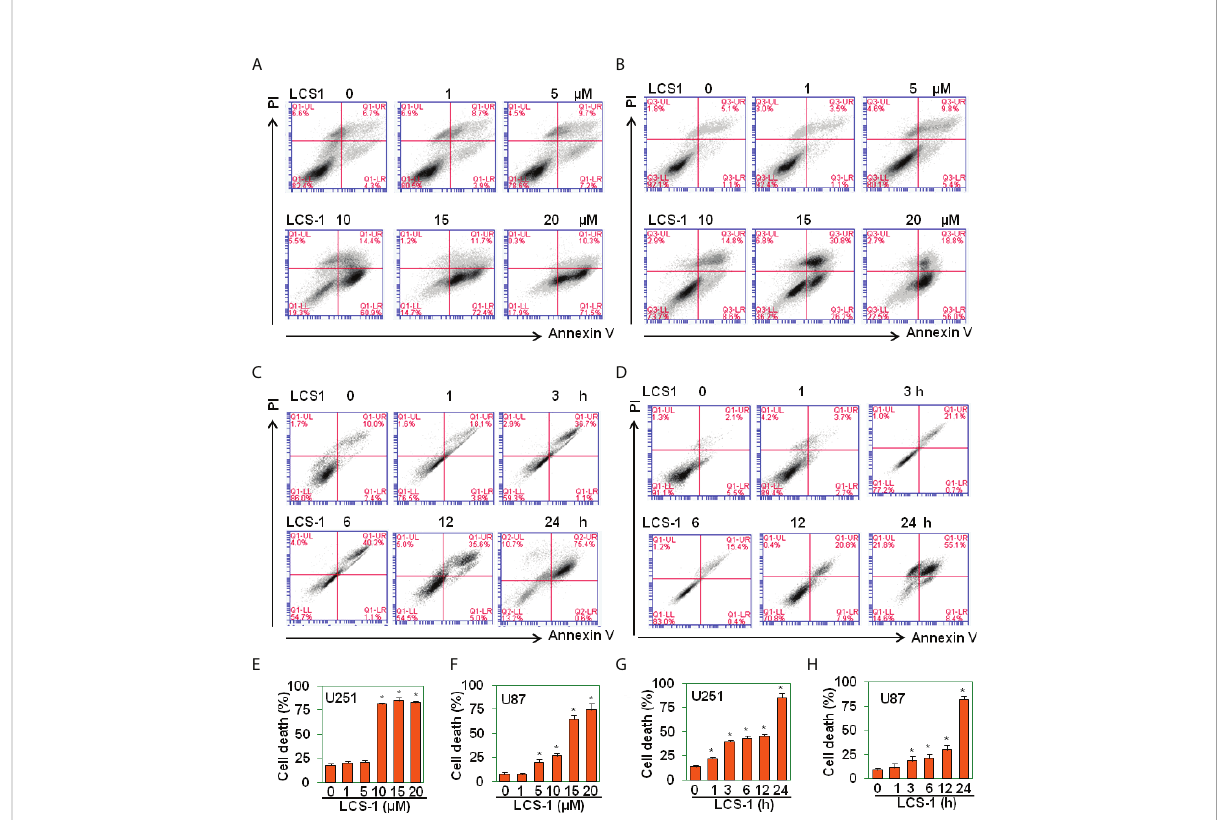
FIGURE 4 LCS-1 induces cell death in glioma cells. (A-B) PI/FITC-Annexin V staining of death of U251 (A) and U87 (B) cells treated with the indicated doses of LCS-1 for 24 h (C, D) PI/FITC-Annexin V staining of death of U251 (C) and U87 (D) cells treated with 20 µM LCS-1 for the indicated time periods. (E-H) Quantitative data from A (E), B (F), C (G) and D (H) respectively. * P < 0.05 compared with the control